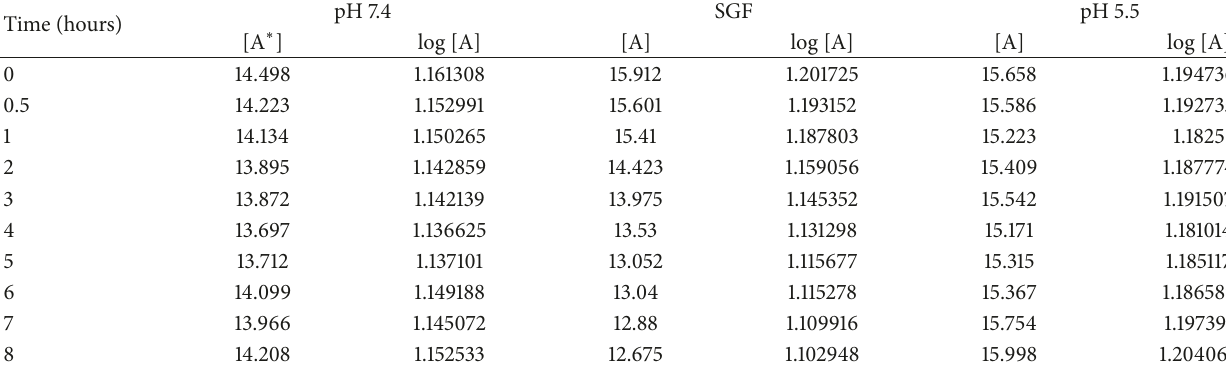
Table 7: The results from the hydrolysis kinetics.